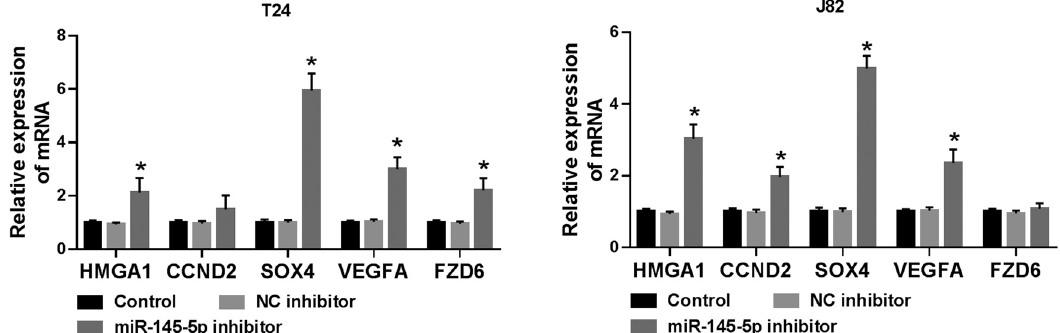
Figure S2: E ff ect of miR - 145 - 5p inhibitor on the expression of its target mRNAs. T24 and J82 cells was transfected NC inhibitor or miR - 145 - 5p inhibitor, respectively. And the mRNA levels of HMGA1, CCND2, SOX4, VEGFA and FZD6 were assessed by RT - qPCR. * P < 0.05.